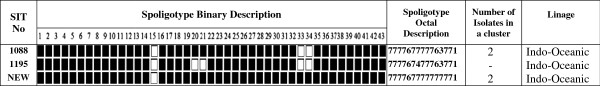
Diagrammatic representation of spoligotype patterns of three clusters of five isolates of M. tuberculosis from five pigs slaughtered in central Ethiopia. The five M. tuberculosis isolates were obtained from TB-compatible tissue lesions of slaughter pigs. These five isolates showed three distinct spoligotype patterns. They were SIT1088 (2 isolates), SIT1195 (one isolate), while two isolates (New) presented identical patterns which had not been reported to the soligotype database before. SIT = Spoligo-International-Typing number according to the SpolDB4/ SITVIT databases [26,27].